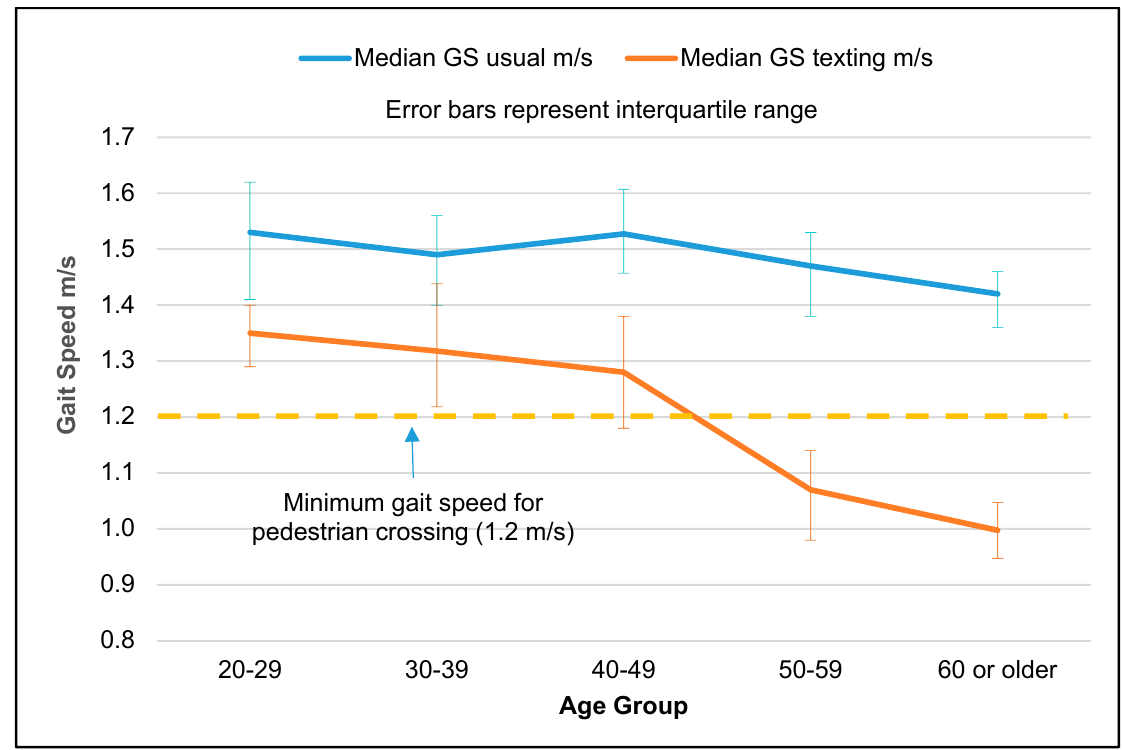
Figure 1. Comparison of gait speed (usual and while texting) by age group.